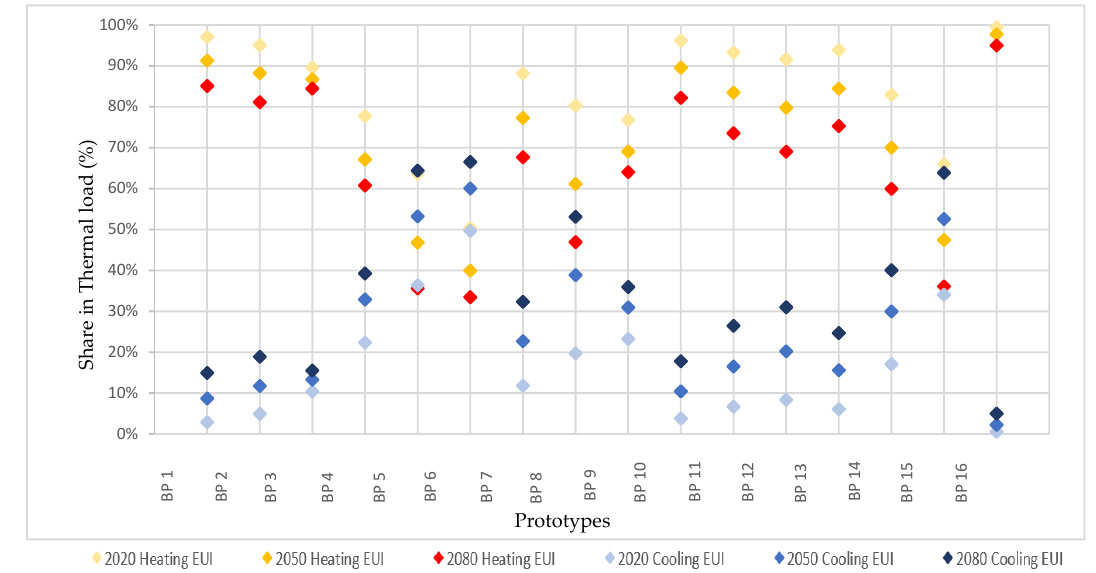
Figure 8. The share of thermal load of building prototypes in 2020, 2050, and 2080.